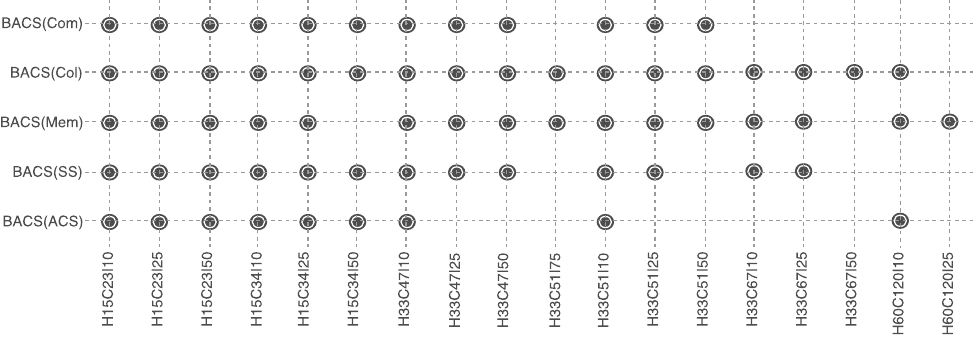
Figure 3. The performance of the algorithms on all instances in terms of feasibility. A dot indicates that an algorithm has identified a feasible solution for an instance.